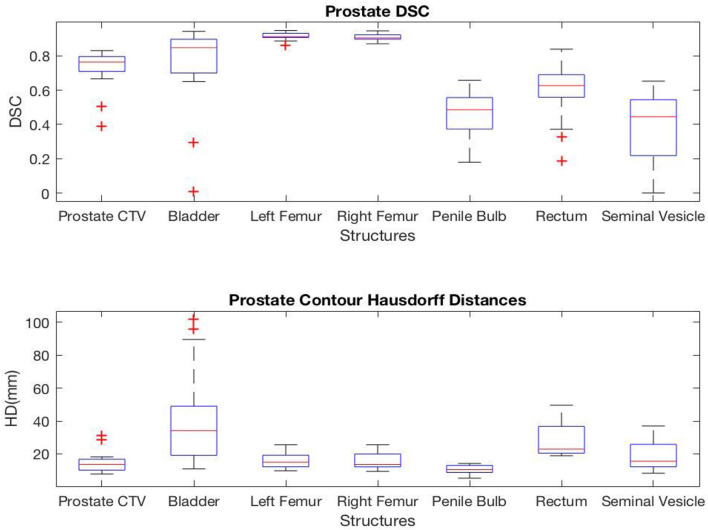
Box plots representing the (Top) DSC and (Bottom) HD for each prostate structures.